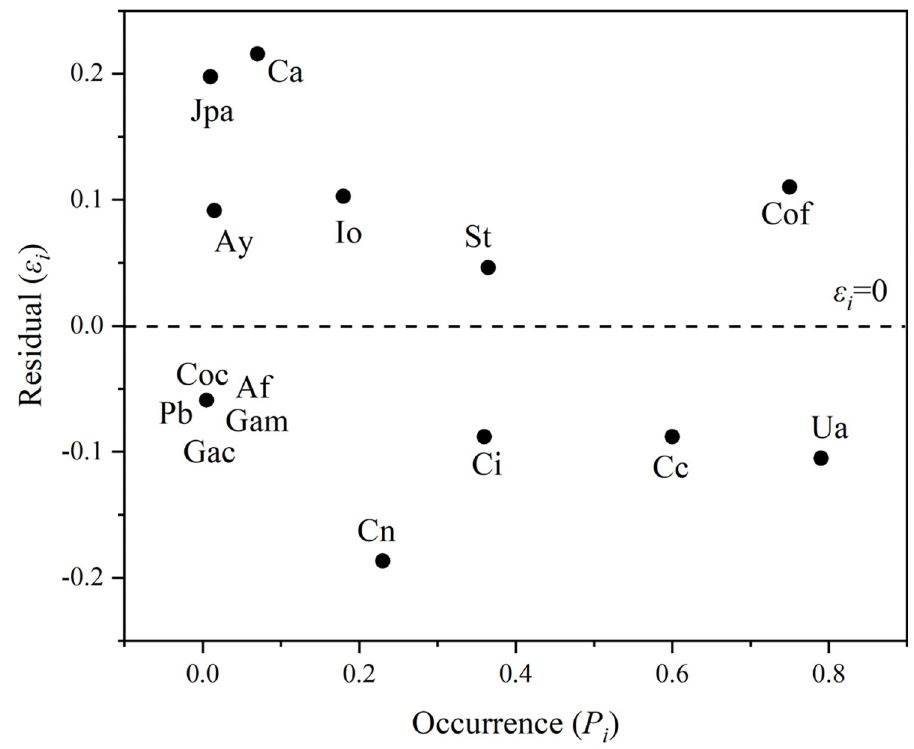
Fig 5. The residuals between the occurrence of individual species and the spatial heterogeneity within the macroalgae community. Chondrus ocellatus (Coc), Chondrus nipponicus (Cn), and Chondria crassicaulis (Cc) were all located below the dashed line ( ε = 0), indicating that the spatial heterogeneity of each species was less than that of the i community, reducing the overall heterogeneity of the community. Jania pedunculata var. adhaerens (Jpa), Callophyllis adnata (Ca), and Corallina officinalis (Cof) were located above the straight line, indicating that their spatial heterogeneity was greater than that of the community and that they have a role in increasing the overall heterogeneity of community structure. C . officinalis (Cof) and Ulva australis (Ua) appeared most frequently, which had a great impact on the overall spatial heterogeneity of the community. Species (black dot) abbreviations: Ishige okamurae (Io), Sargassum thunbergia (St), Alatocladia yessoensis (Ay), Chondracanthus intermedius (Ci), Grateloupia acuminata (Gac), Ahnfeltiopsis flabelliformis (Af), Gelidium amansii (Gam), Petalonia binghamiae (Pb).